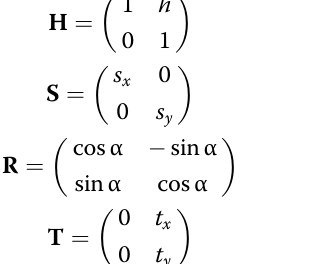
Fig. 7e, the grid is retrieved for TEM analysis and a similar overview image is acquired (compare Fig. 7a). Fig. 7f shows the same folds and outlines as in Fig. 7b, as highlighted by the blue frame. Fig. 7g is a magni fi ed crop of the TEM area in Fig. 7f where parts of the cells are recognised as seen in confocal re fl ection Fig. 7c. Fig. 7h shows an overlay of the re fl ection, FWM and TEM area. A high-resolution TEM image is shown in Fig. 7i for the region indicated by the orange frame in d,h. An overlay of the AuNPs seen in FWM (yellow) and this TEM area is provided in Fig. 7j, where the nucleus has been highlighted in blue, the mitochondria in red and segments of the plasma membrane in